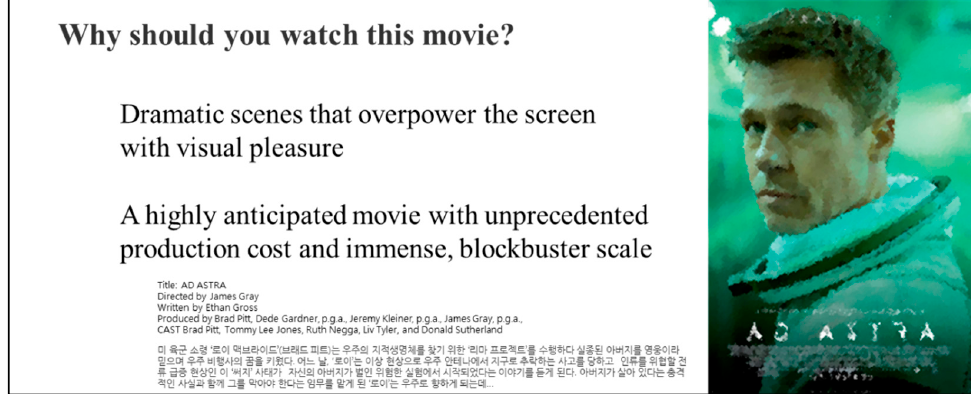
Figure A4. Upcoming releases recommended by watcha (abstract